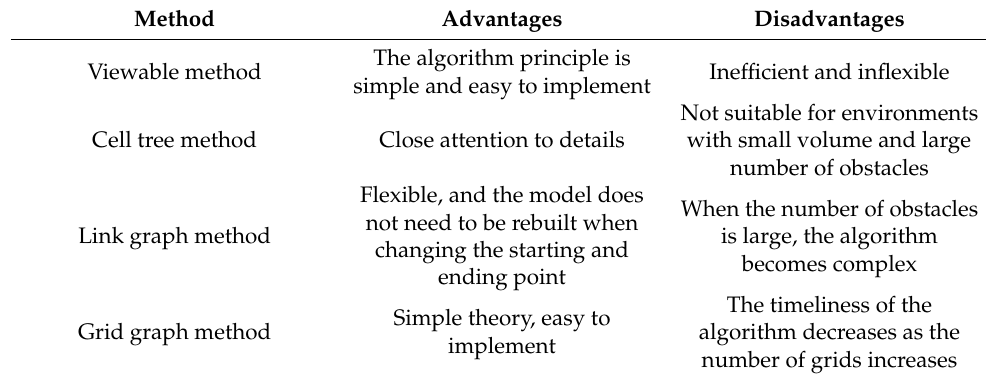
Table 1. Comparison of advantages and disadvantages of the four modeling methods.